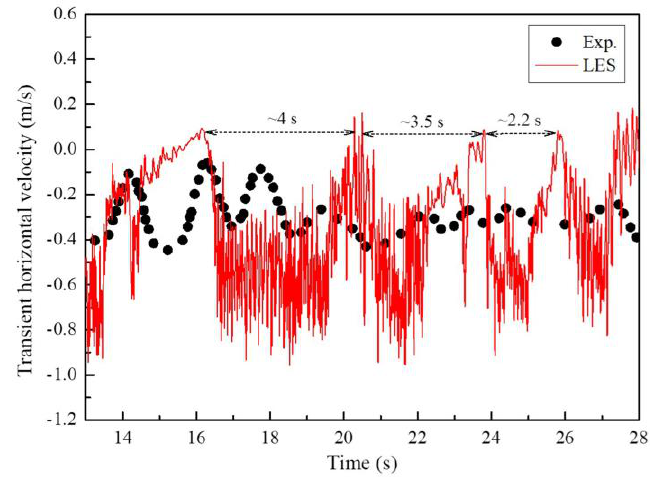
Figure 7. Transient horizontal velocity history at point 1 (Figure 2).